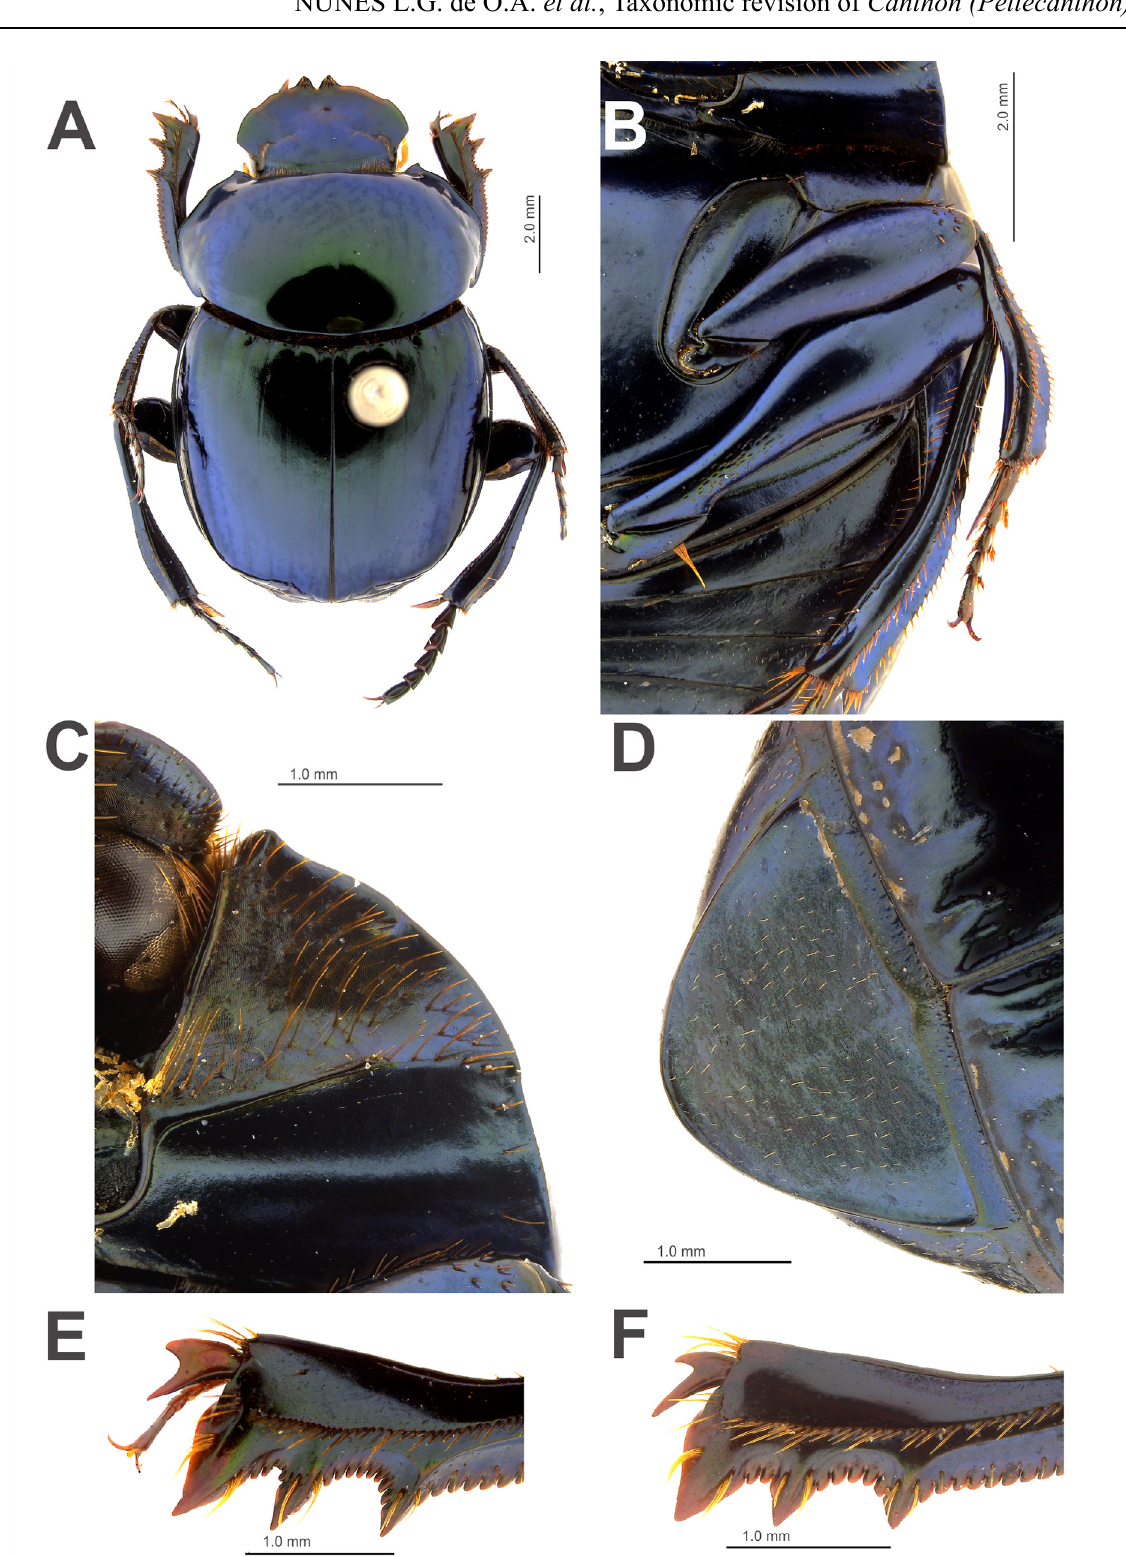
Fig. 1. Canthon ( Peltecanthon ) staigi (Pereira, 1953), ♂, São Paulo, Bertioga (CEMT). A . Dorsal habitus. B . Ventral surface of meso- and metafemora. C . Transverse carina in the hypomeron. D . Carina in the margin between pygidium and propygidium. E . Male protibial spur. F . Female protibial spur, São Paulo, Caraguatatuba, P.E. Serra do Mar